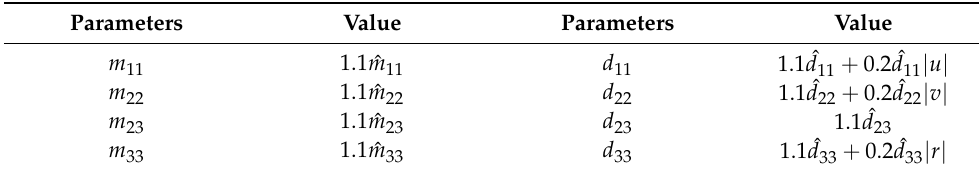
Table 1. Actual values of CS2.